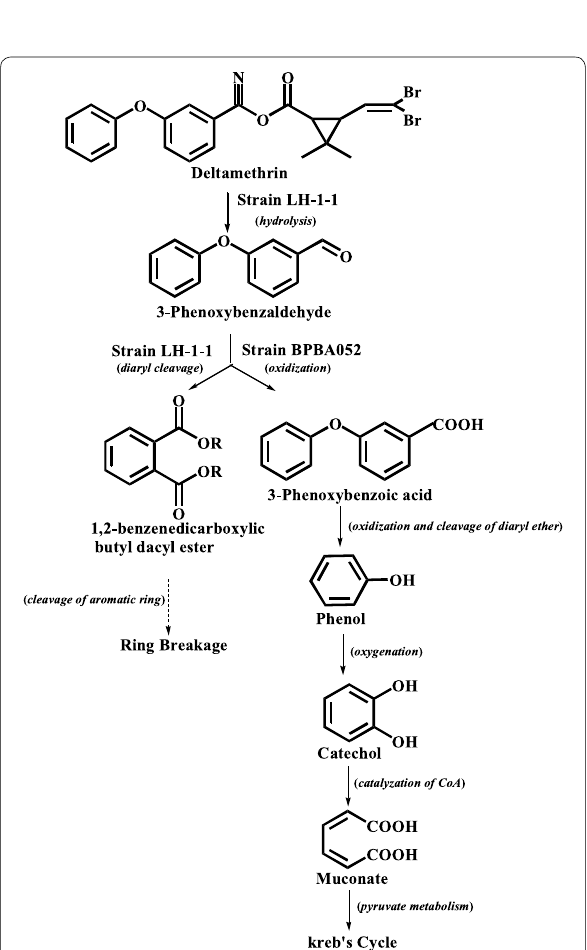
Fig. 6 Proposed biodegradation pathway of deltamethrin and its metabolite 3-PBA by the co-culture of strains A. junii LH-1-1 and K. pneumoniae